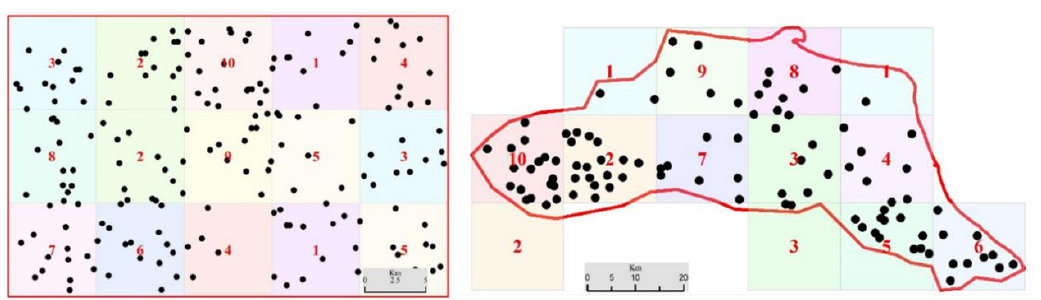
Figure 3. Illustration of the spatial blocking strategy in two regions. The numbers in the blocks are fold numbers, showing allocation of blocks to folds.